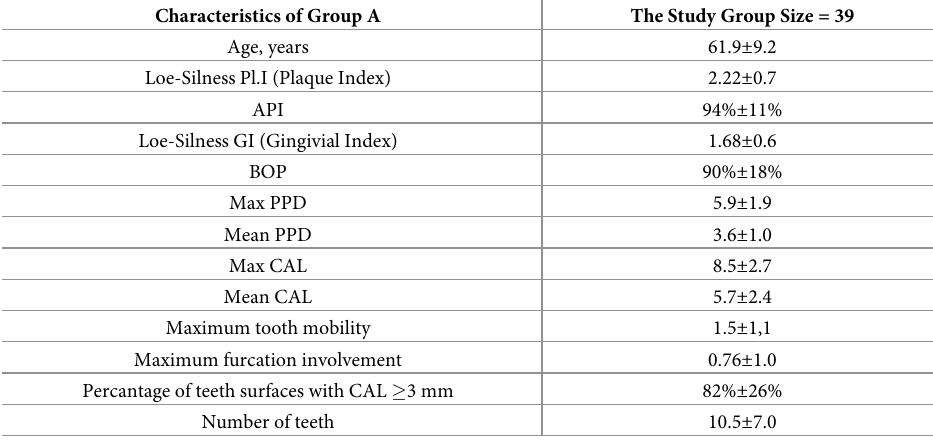
Table 4. Clinical characteristic of the study group. Data are shown as the mean ± SD.